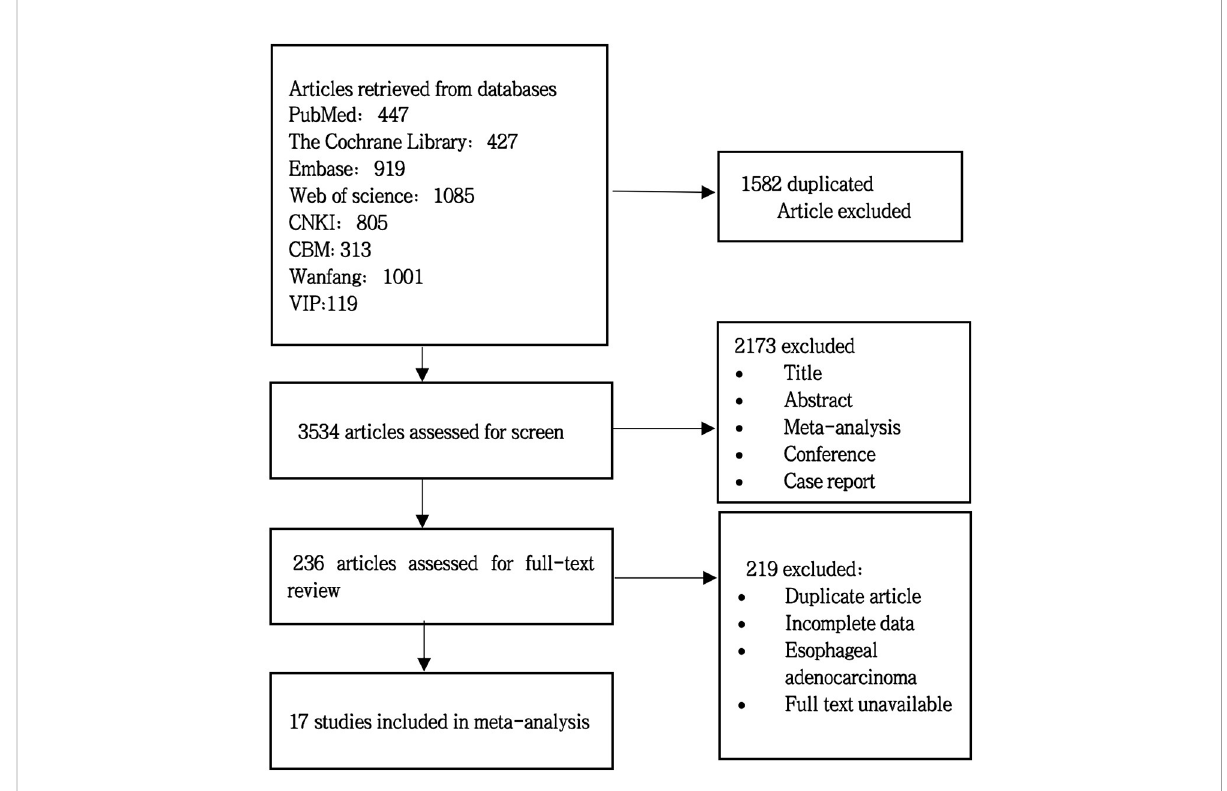
FIGURE 1 Literature screening fl